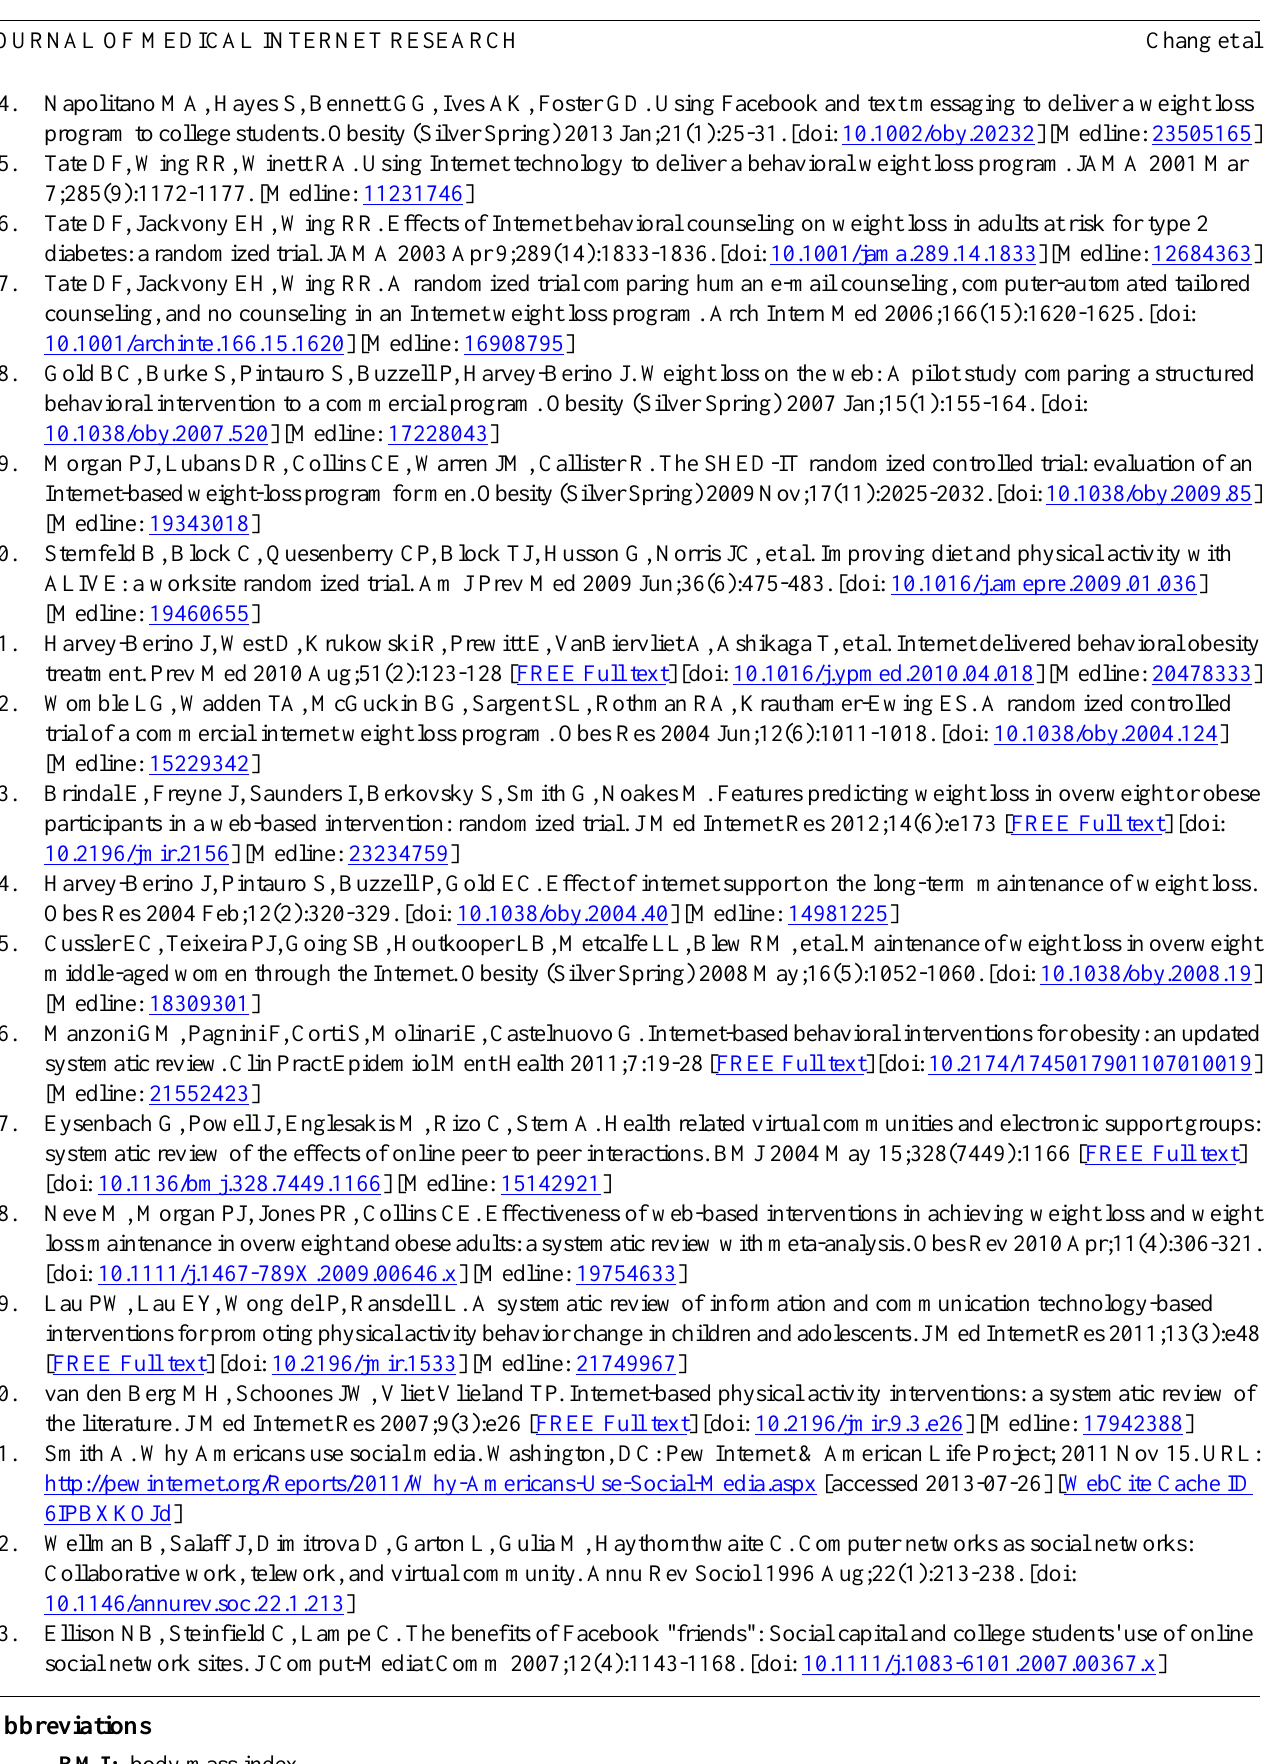
Abbreviations BMI: body mass index MeSH: Medical Subject Heading PRISMA: Preferred Reporting Items for Systematic Reviews and